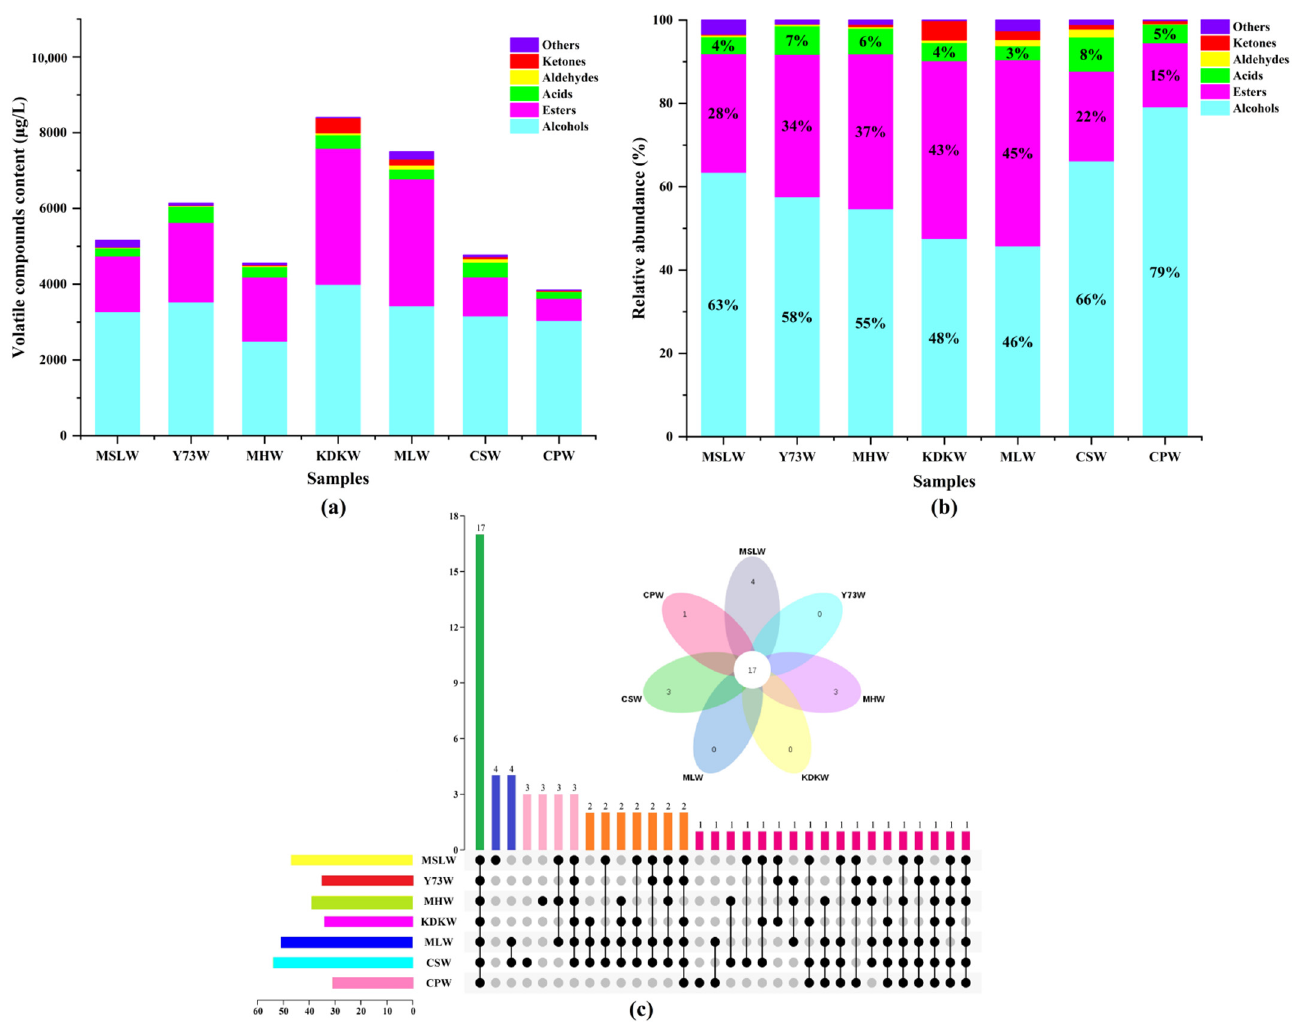
Figure 8. The composition of volatile compounds in wines produced from seven different grape varieties ( a ). The relative abundance of volatile compounds in all wines ( b ). The Venn diagram and upset plot of all wines ( c ). In the upset plot, black dots indicate the common aroma compounds in different wines. Samples’ full names, as follows: MSL (Marselan), Y73 (Yan 73), MH (Muscat Hamburg), KDK (Kadarka), ML (Merlot), CS (Cabernet Sauvignon) and CP (Crimpose). Furthermore, G represents “grape” and W represents “wine”.